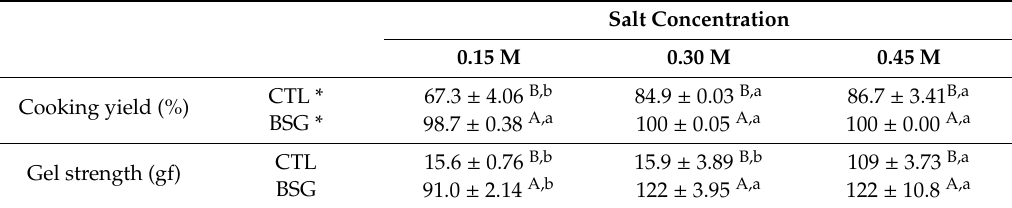
Table 3. Cooking yield and gel strength of myofibrillar protein mixtures with basil seed gum at di ff erent salt